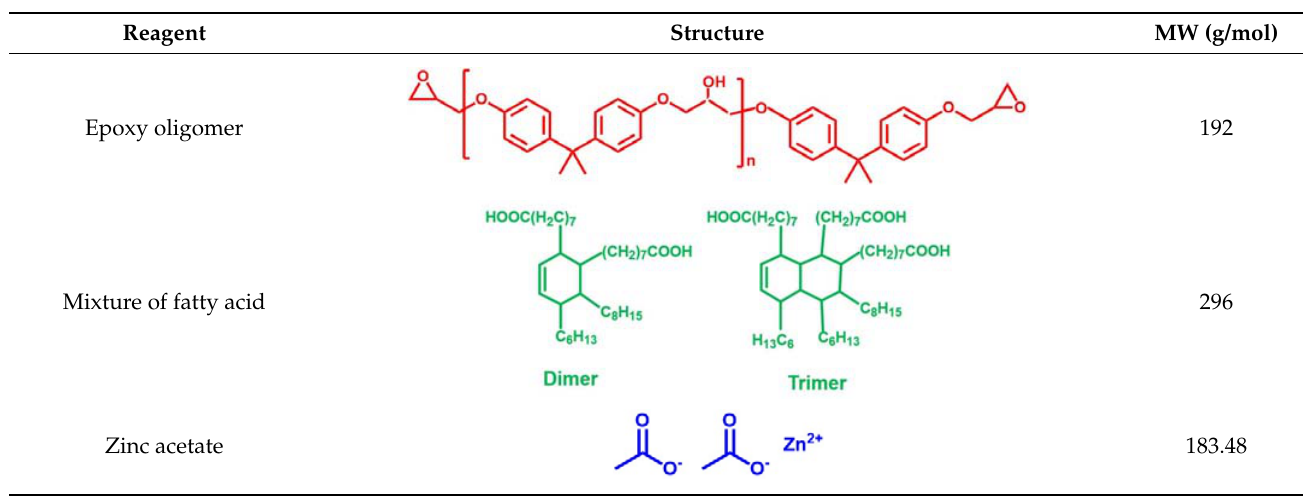
Table 1. Chemical structures and molecular weights (MWs) of reagents.